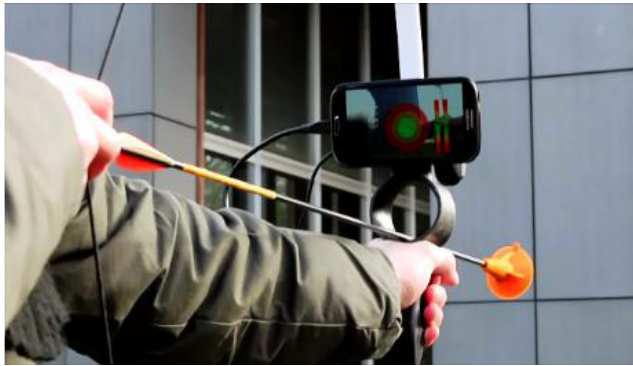
Figure 2. ArcAid in action. By using the app information on the smartphone, the user can adjust the drawback on the bow string or adapt the angle of the bow to be able to hit the target.